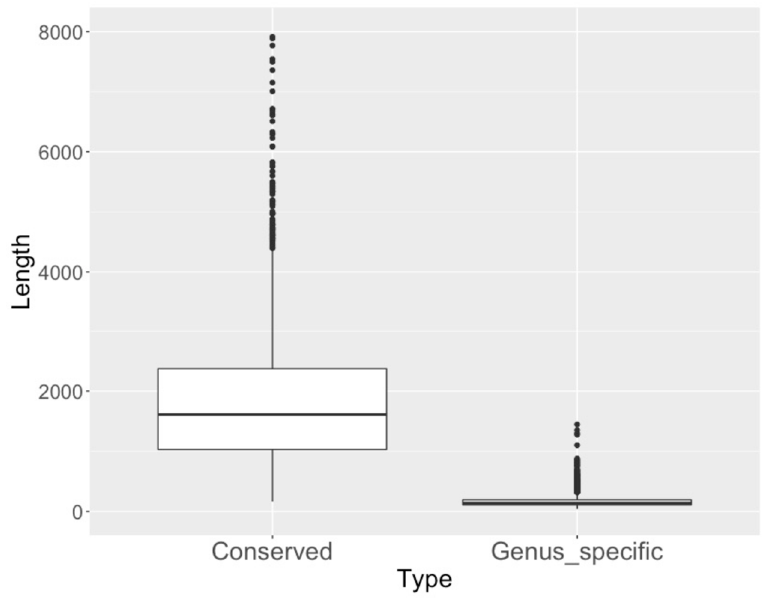
Figure 2. Length of genus-specific and conserved genes. Legend Figure 2: Lengths ( Y -axis) of conserved and differentially expressed genus-specific proteins.